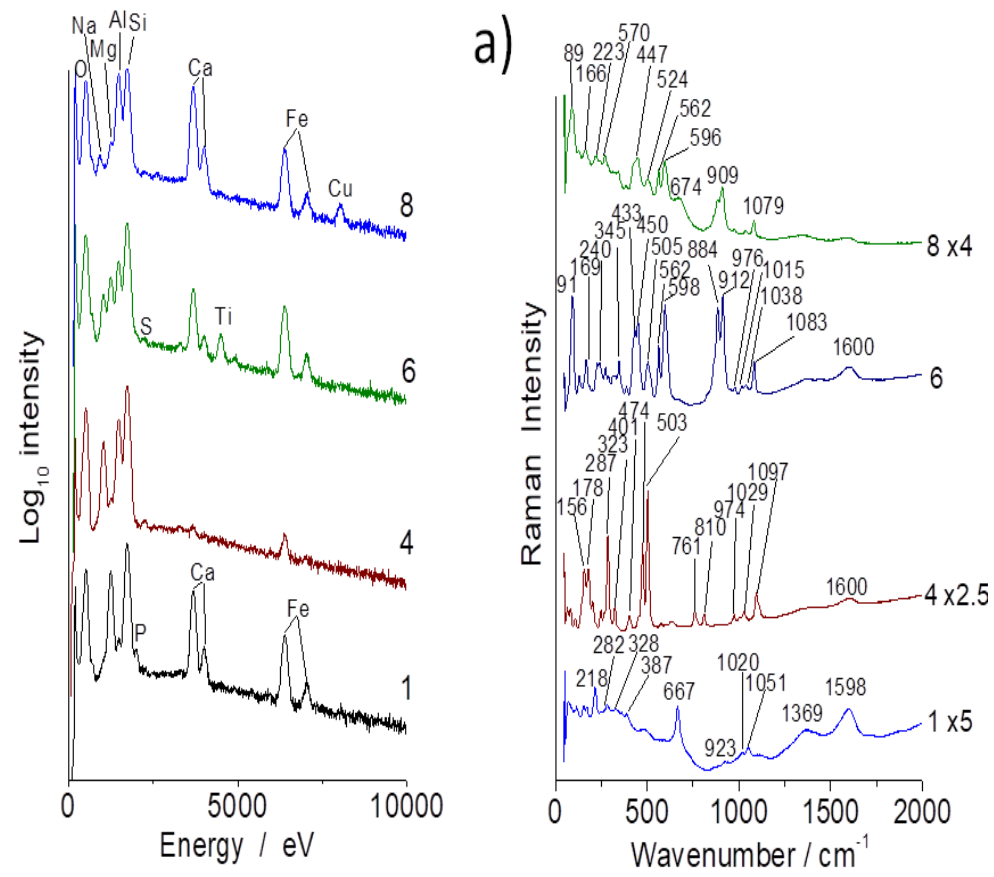
Figure A2. XRPD pattern for specimen b. XRPD patterns of indexed phases: heated actinolite (PDF# 01-089-5367), quartz (PDF# 00-001-0649), crocidolite (riebeckite) (PDF# 00-027-1415), diopside (PDF# 00-017-0318), orthopyroxene (PDF# 01-076-3331), antigorite (PDF# 00-007-0417), chlorite–serpentine (NR) (PDF# 00-052-1044), tremolite (PDF# 01-086-1319) and albite (PDF# 01-089-6425) are presented in form of straight intensity lines at the bottom of the pattern.